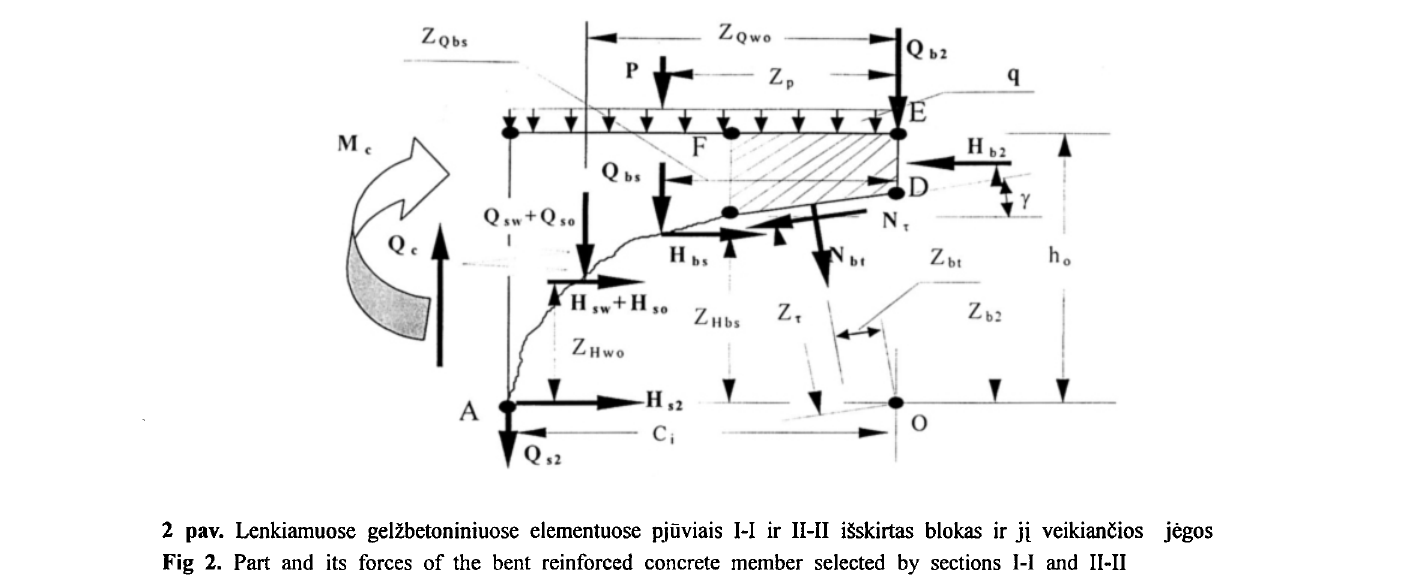
Fig 2. Part and its forces of the bent reinforced concrete member selected by sections 1-1 and 11-11 H ir H - atitinkamai istrifu plysiu kertamose ,\W